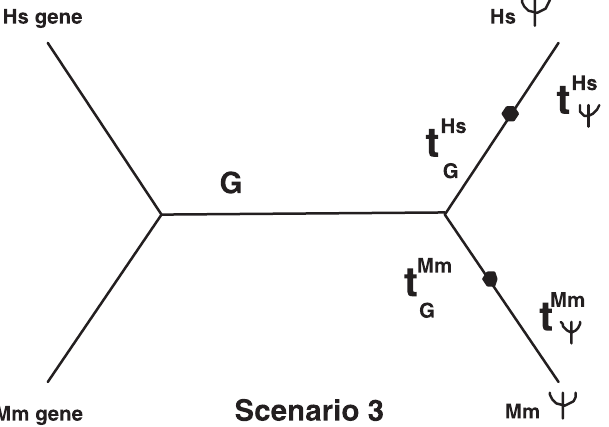
Figure 7. S 3 Topology with Gene-to-Pseudogene Breakpoints t Hs G refers to the length of the branch on which the human pseudogene has evolved genelike, and similarly for t Hs w , t Mm G , t Hs w . DOI: 10.1371/journal.pcbi.0020046.g007 PLoS Computational Biology |